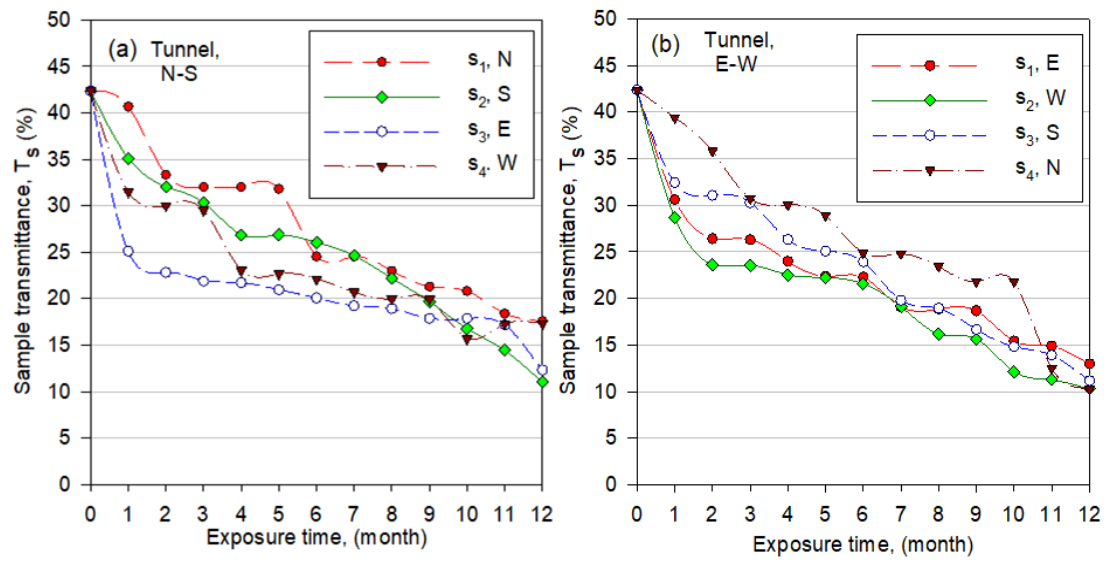
Figure 3. Degradation of the sample transmittances ( T s ) with the exposure time for the tunnel prototype, oriented in the N–S ( a ) and E–W ( b ) directions under arid climatic conditions.